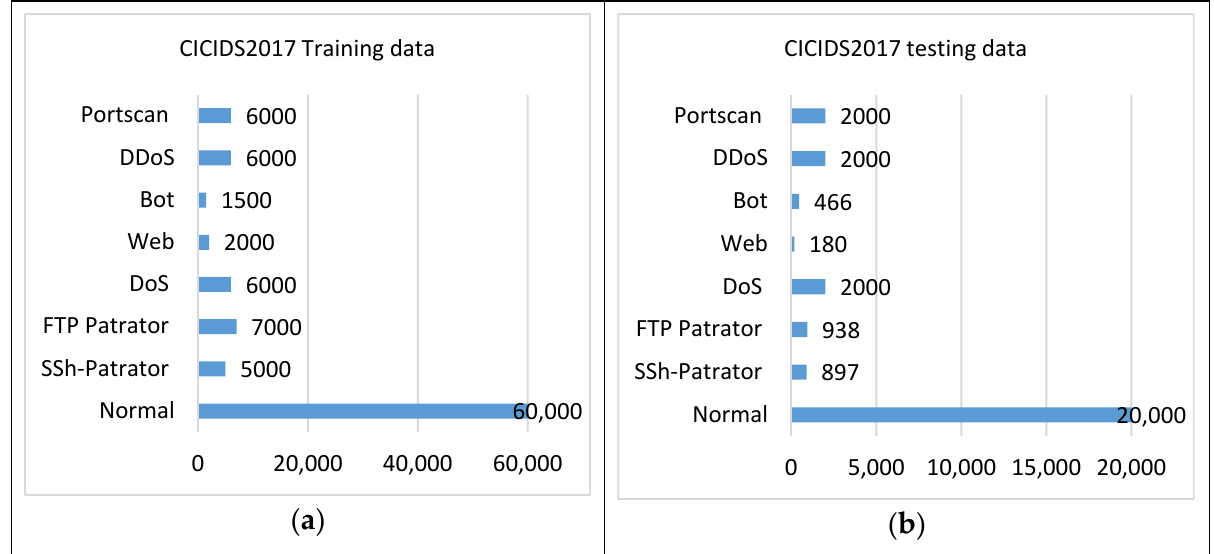
Figure 9. CICIDS2017 ( a ) training data and ( b ) testing data.